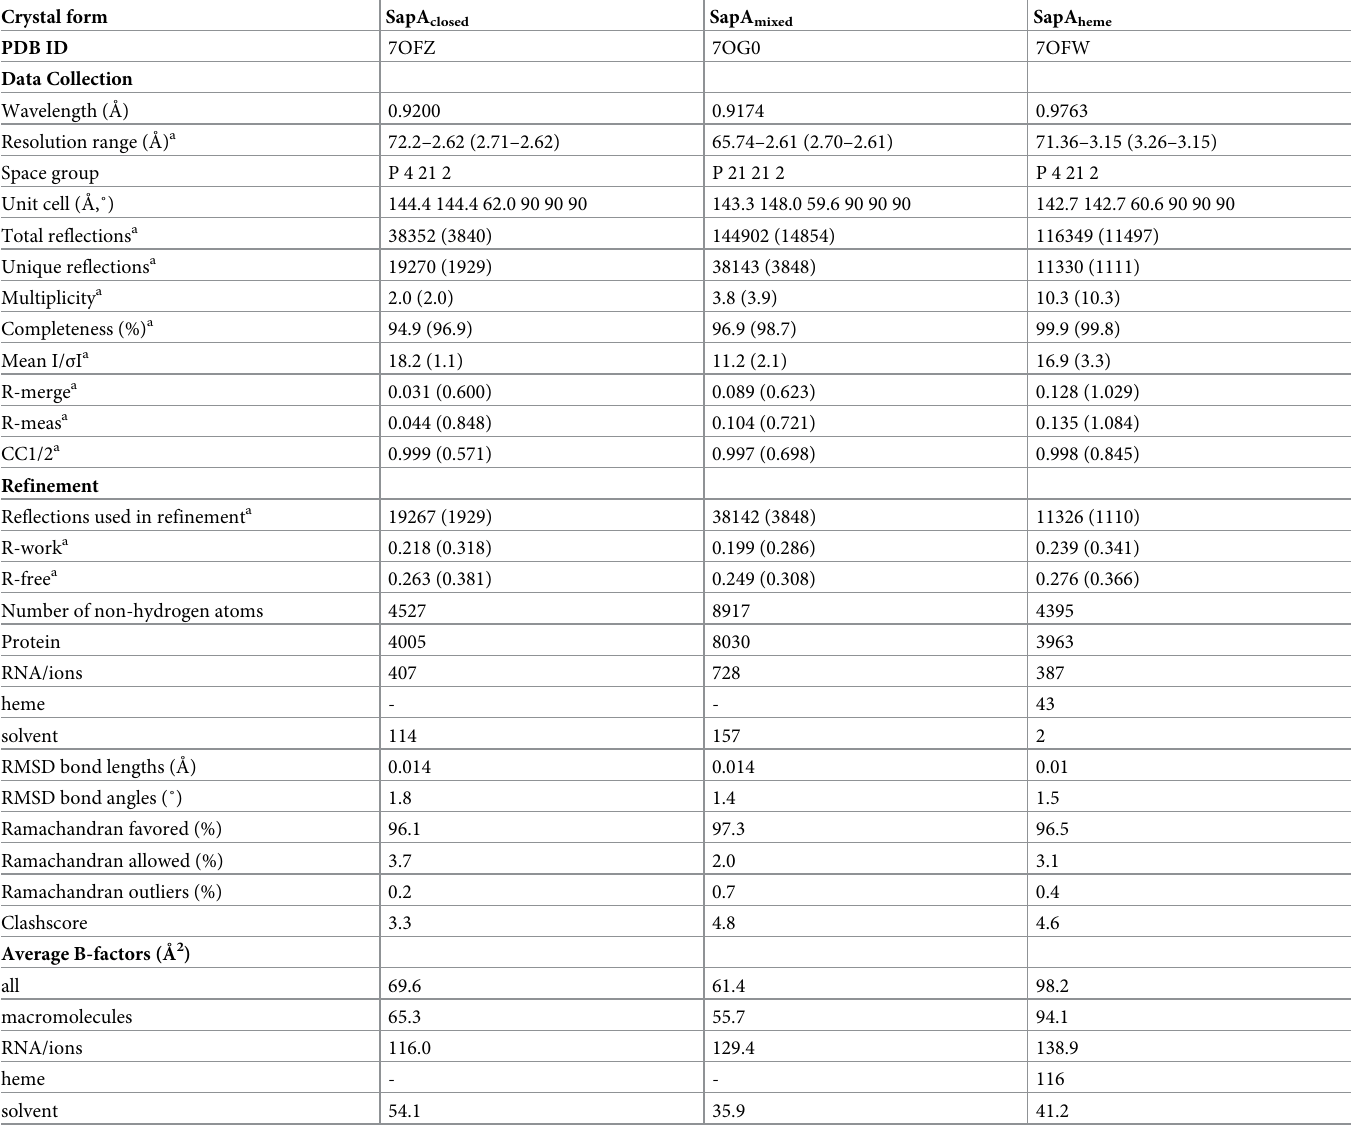
Table 1. Crystallographic data collection and refinement